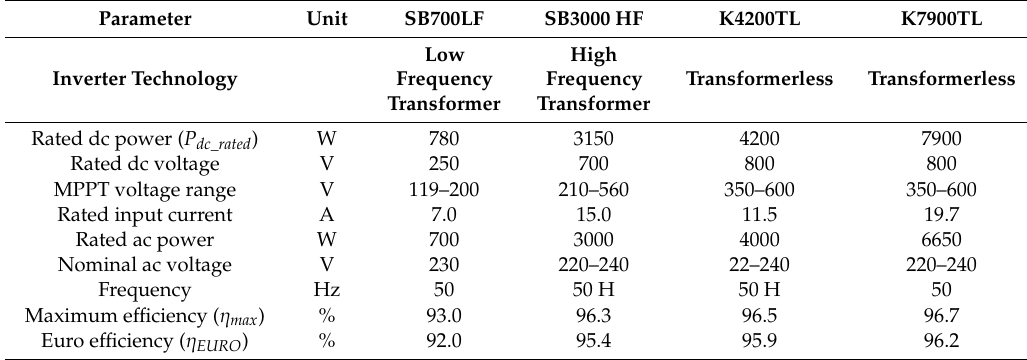
Figure 8. Actual PV inverter test set-up. Table 2. The electrical properties of the tested PV